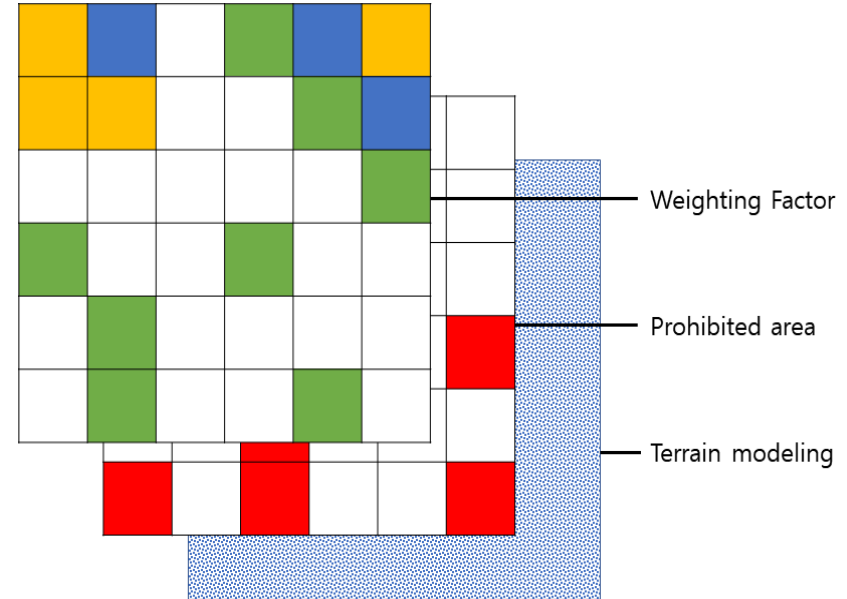
Figure 5. Terrain Modeling with Necessary Factors.